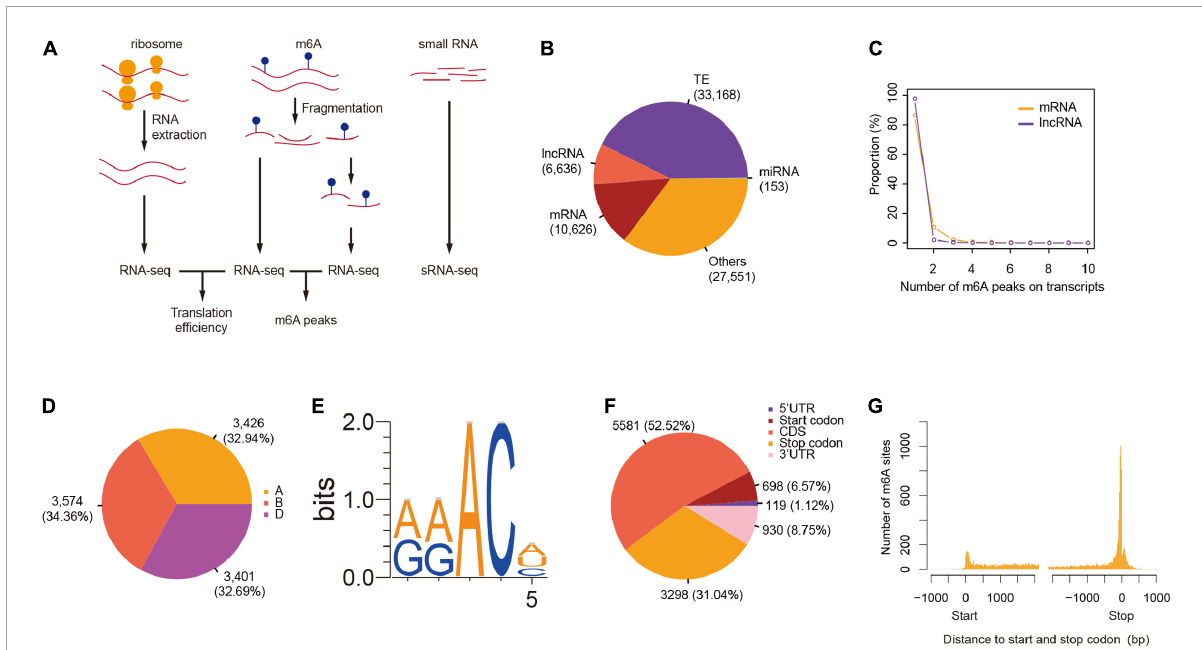
FIGURE1 Transcriptome-wide identification of m6A in wheat. (A) A scheme showing the protocols of RNC-seq, RNA-seq, m6A-seq, and small RNA-seq. (B) The number of m6A peaks in different class of RNAs. (C) The number of m6As per transcript. (D) The distribution of m6A-containing mRNAs across sub-genomes. (E) The consensus motif of m6A sites. (F) The distribution of m6A peaks on mRNAs. (G) The distance between m6A peaks and start and stop